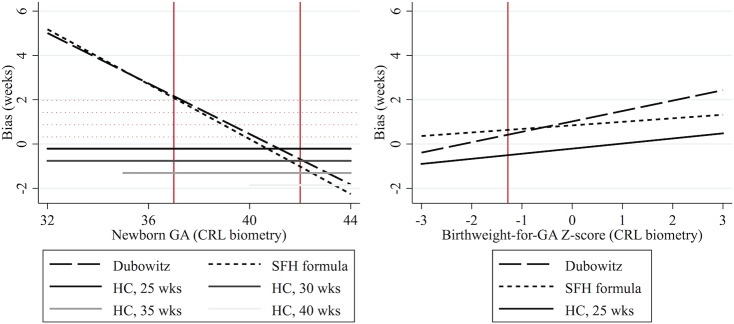
Crude comparison of biases associated with alternative methods of estimating gestational age.GA: gestational age estimated from CRL biometry. CRL: crown-rump length. SFH: symphysis fundal height. HC: head circumference, measured at 25, 30, 35 or 40 weeks gestation. Solid red vertical lines delineate cut-offs for preterm (<37 weeks) and post-term (>41 weeks) newborns, and small for gestational age (Z-score <-1.28) newborns. Dotted red horizontal lines are mirrors of HC bias to facilitate visual comparison.